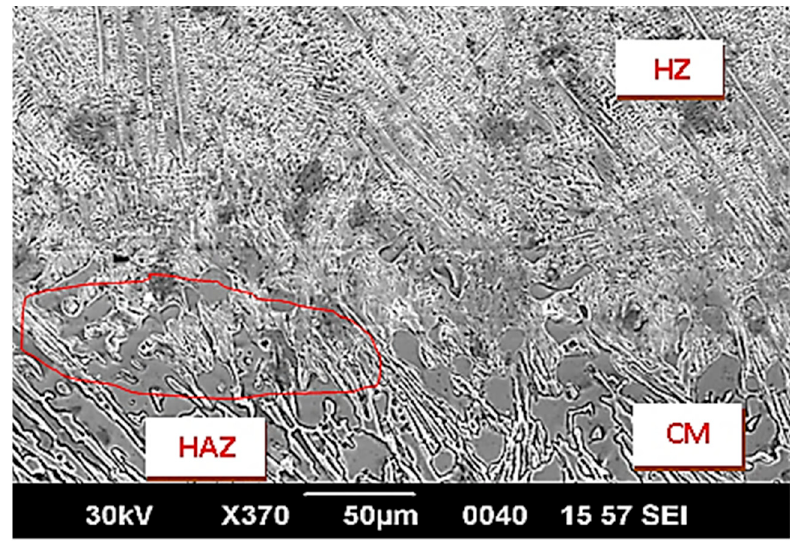
Figure 9. SEM microstructure: of the HZ and the HAZ of S2-1–3 sample.